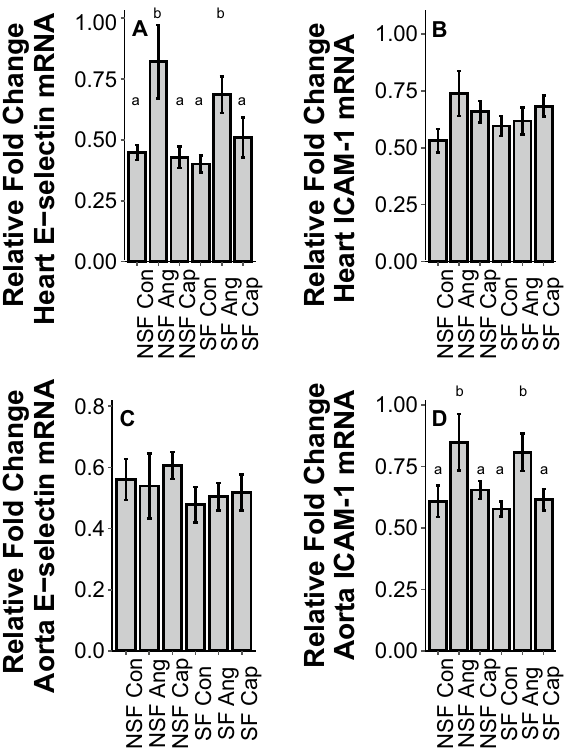
Figure 3. Effects of sleep fragmentation, RAS manipulation, and their interaction on E-selectin and ICAM-1 gene expression in circulatory tissues, heart ( A , B ) and aorta ( C , D ). Samples sizes are ( A ) NSF-Con n = 10, NSF-Ang n = 10, NSF-Cap n = 10, SF-Con n = 9, SF-Ang n = 9, and SF-Cap n = 10, ( B ) NSF-Con n = 10, NSF-Ang n = 10, NSF-Cap n = 10, SF-Con n = 10, SF-Ang n = 8, and SF-Cap n = 10, ( C ) NSF-Con n = 11, NSF-Ang n = 10, NSF-Cap n = 10, SF-Con n = 9, SF-Ang n = 9, and SF-Cap n = 9, ( D ) NSF-Con n = 11, NSF-Ang n = 9, NSF-Cap n = 10, SF-Con n = 9, SF-Ang n = 9, and SF-Cap n = 10. All data were analyzed using a two-way ANOVA and Tukey’s HSD post hoc tests. Data shown as means ± 1 SE for each group and differing lowercase letters denotes p <